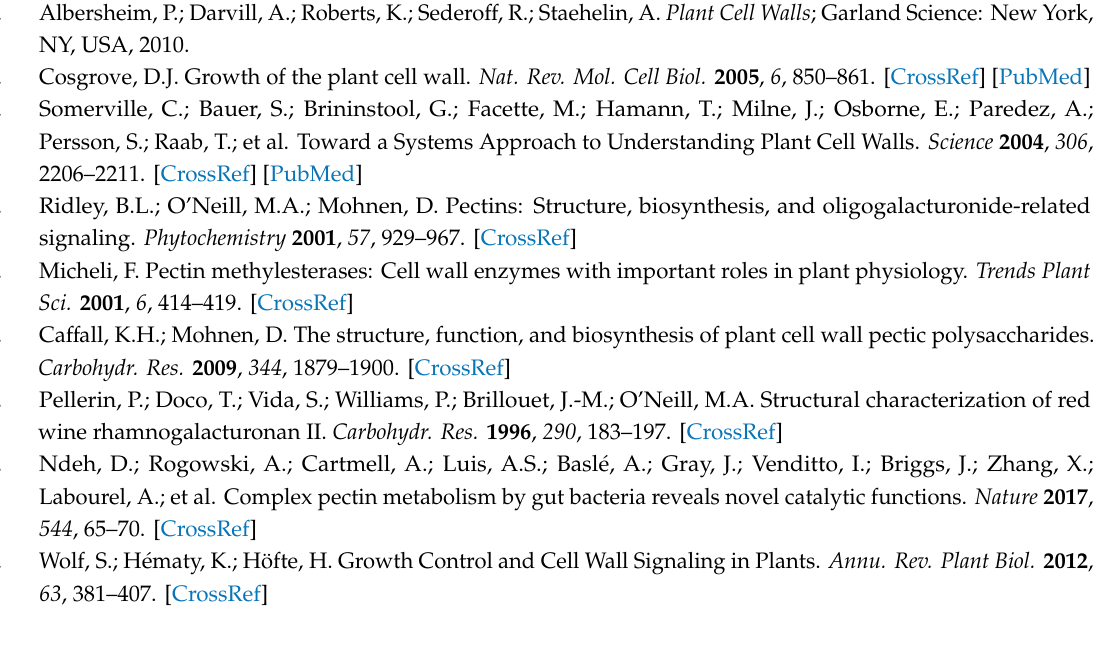
Figure S1: Comparison of root lengths under optimal and osmotic-stressed conditions, Table S1: Primers used for